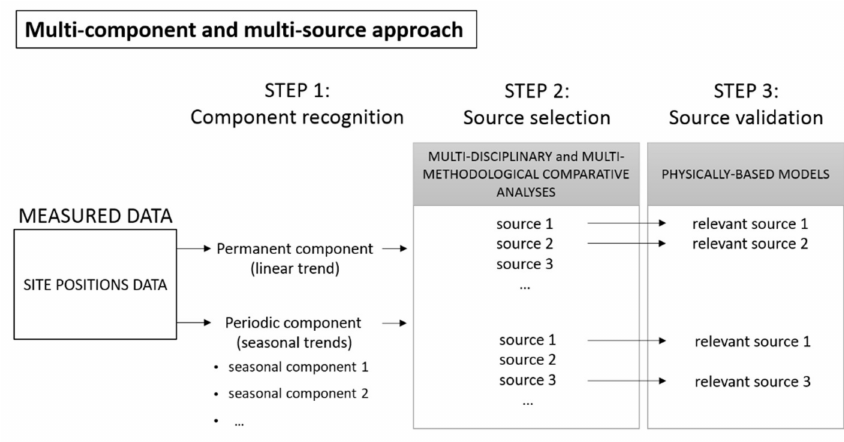
Figure 1. Scheme of the proposed methodological